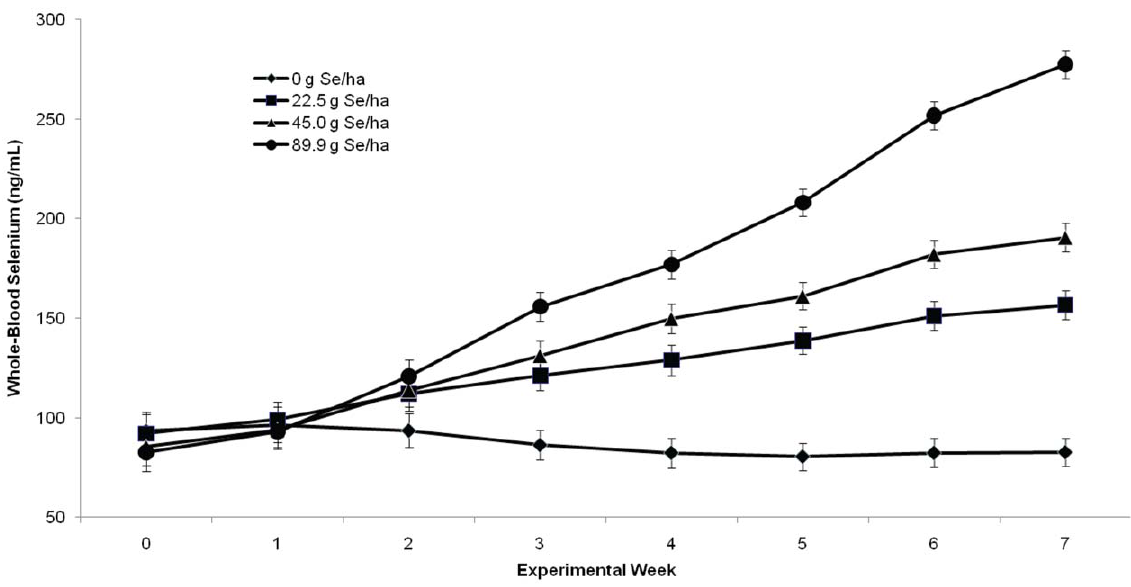
Figure 2. Comparison of whole-blood Se concentrations (mean 6 SEM) in weaned beef calves consuming alfalfa hay grown in fields not fertilized with Se (0 g Se/ha), or harvested from fields fertilized with sodium-selenate at an application rate of 22.5, 45.0, or 89.9 g Se/ha for 7 wk (n=15 calves per group). The normal reference interval for whole-blood Se concentrations of beef cattle is 120 to 300 ng/mL.